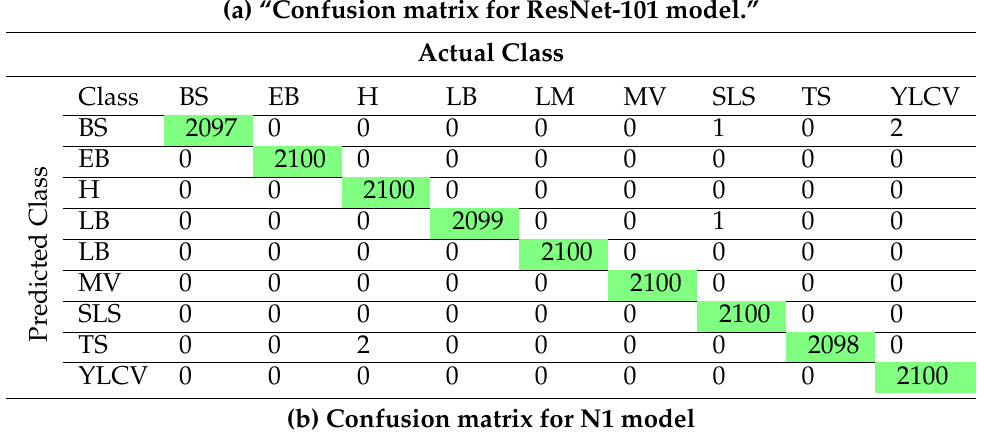
(b) Confusion matrix for N1